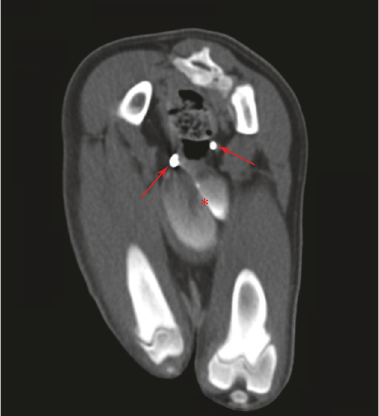
Figure 3: Transverse CT image at the level of the ischium with non- ionic, iodinated contrast medium demonstrating a septate urinary bladder ( ∗ ) and two distinct urethras (arrows).